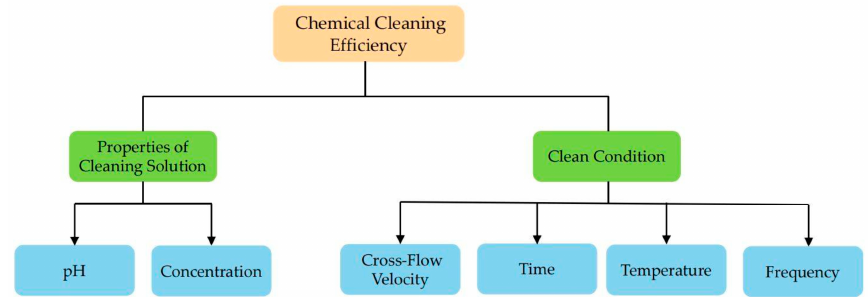
11 of 22 Figure 4. Schematic of NF membrane fouling and HS-DOBW cleaning. Reproduced with permission from Reference [115]. Copyright 2015, Elsevier. 5.2. Chemical Cleaning In long-term operation, once physical cleaning cannot restore the membrane flux to